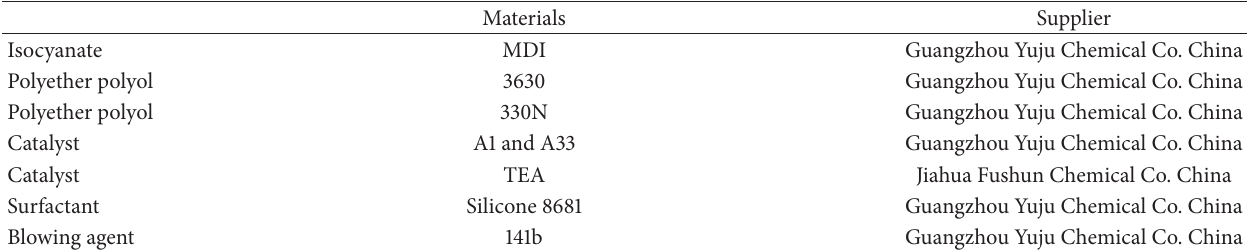
Table 1: Major characteristic of the materials.